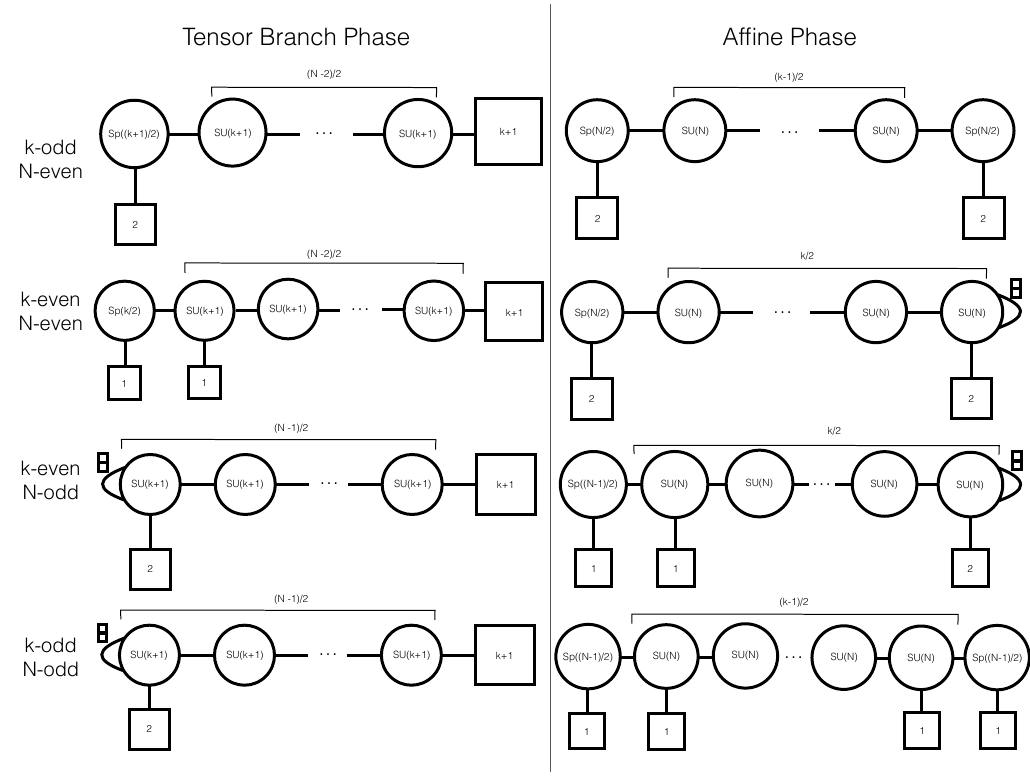
Figure 3 . Resulting quiver theories for A-type class S theories associated with the brane systems (cid:0) in 2. On the left the reduction on the tensor branch to 4D, on the right the reduction at the (cid:12)xed point. The possible cases are listed depending on k and N even or odd. The double box labeling some matter on the right or left gauge nodes stands for a full antisymmetric hypermultiplet.